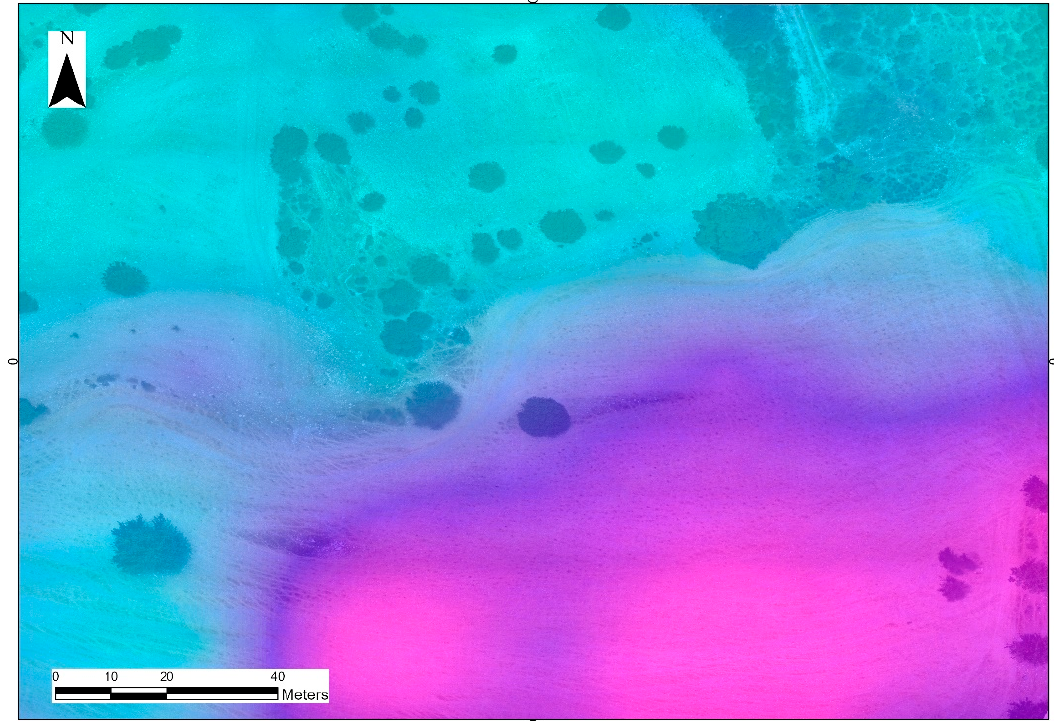
Figure 12. Potsherd distribution from the ground-truthing pedestrian survey in Area 6. Areas indicated with purple colour show a higher concentration of potsherds, while those in blue indicate thinner ceramic concentrations.